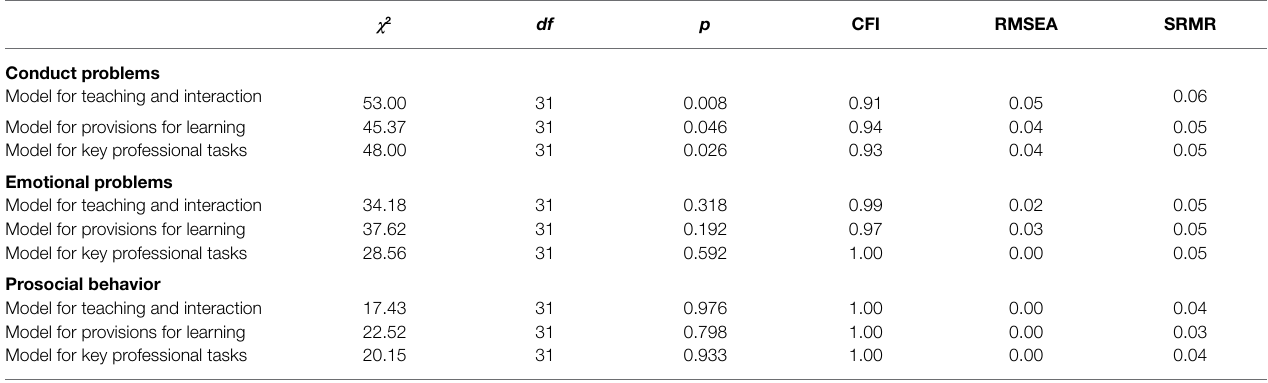
TABLE 3 | Model fit indices of the structural equation models.